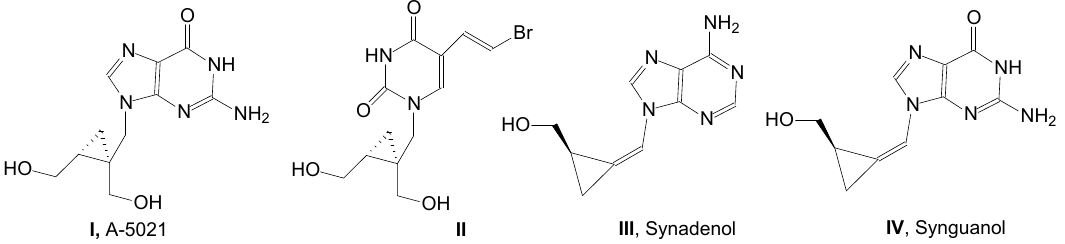
Figure 1. 1 (cid:48) -Homonucleosides with a cyclopropane ring in the sugar Figure 1. 1 ′ -Homonucleosides with a cyclopropane ring in the sugar moiety.